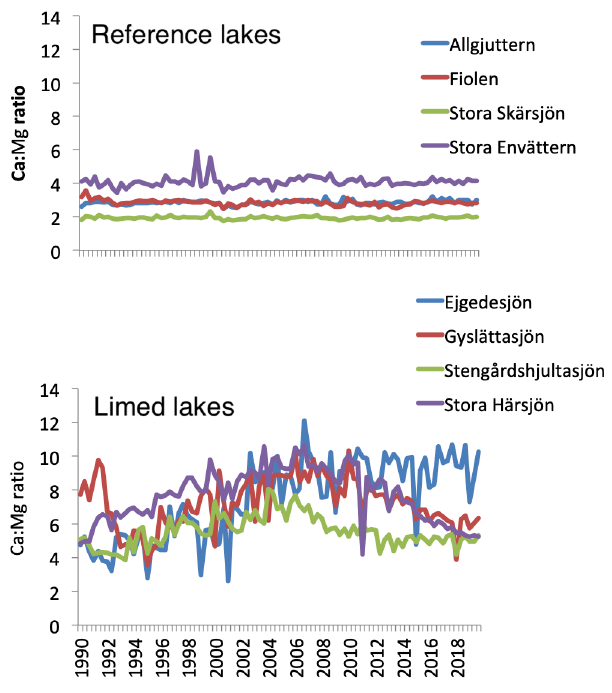
Table 1 . Summary statistics of AEM-RDA models. Not applicable (na) because axes were not significant. Adjusted R² min. model